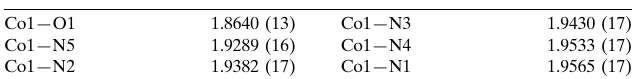
Selected bond lengths (A˚ ).